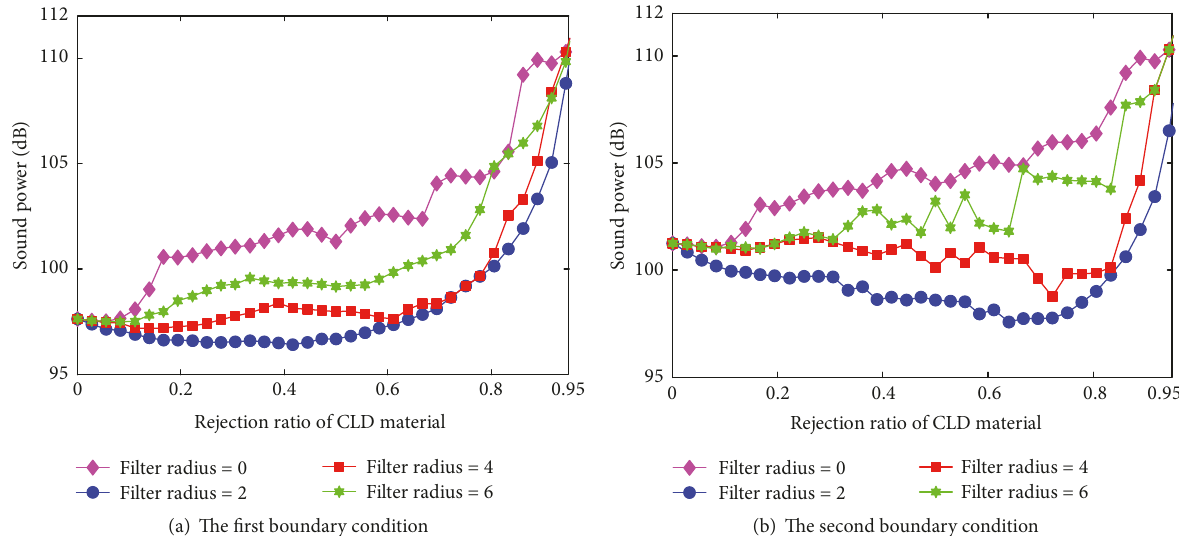
Figure 6: Relationship between sound power and rejection ratio of CLD materials under various filter radius.